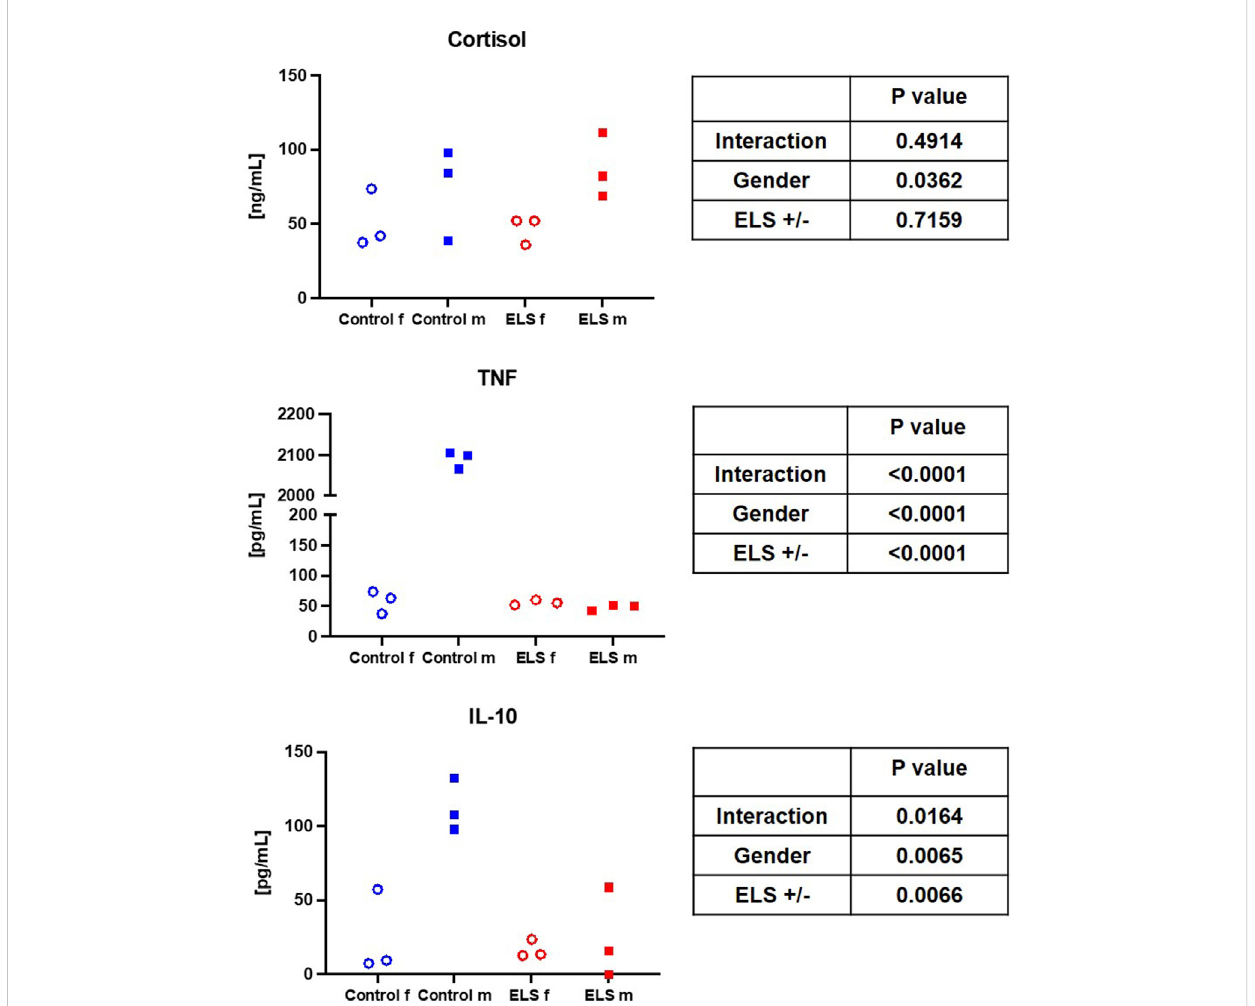
FIGURE 1 Serum cortisol, tumor necrosis factor (TNF, left panel) and interleukin-10 (IL-10, right panel) levels in the in the control (blue symbols) and Early Life Stress (ELS; red symbols) groups separated for male ( “ m ” , solid squares) and female ( “ f ” , open circles) swine. Note that male control animals showed markedly higher cytokine concentrations than females, while there was no sex-related difference in the ELS